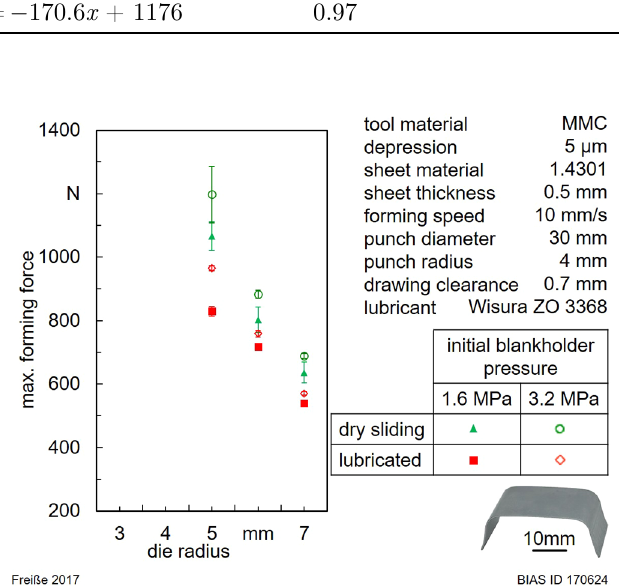
Fig. 16. Maximum forming forces using MMC tool with 5 m m depression.